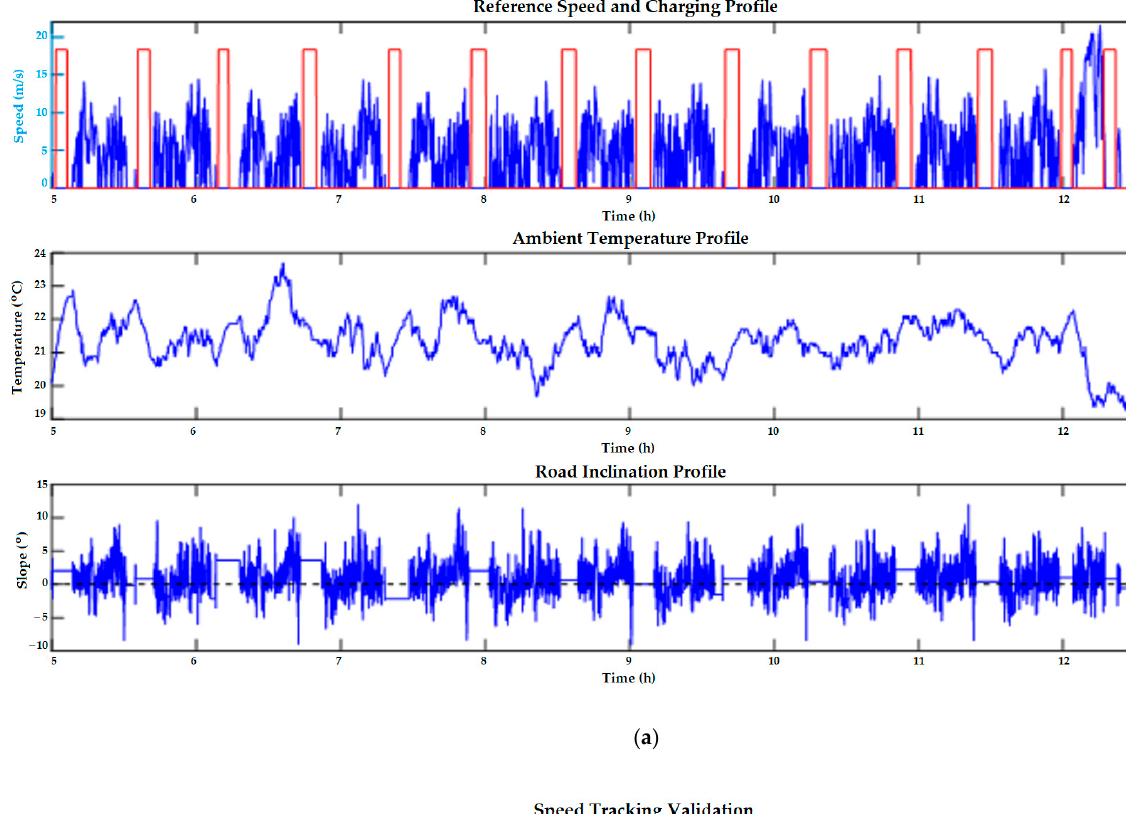
Figure 10. Validation of the May 27th demonstration of 12 m bus in Gothenburg city using the esti ‐ mates in Table 6. ( a ) Scenario inputs, ( b ) Scenario outputs and validation.